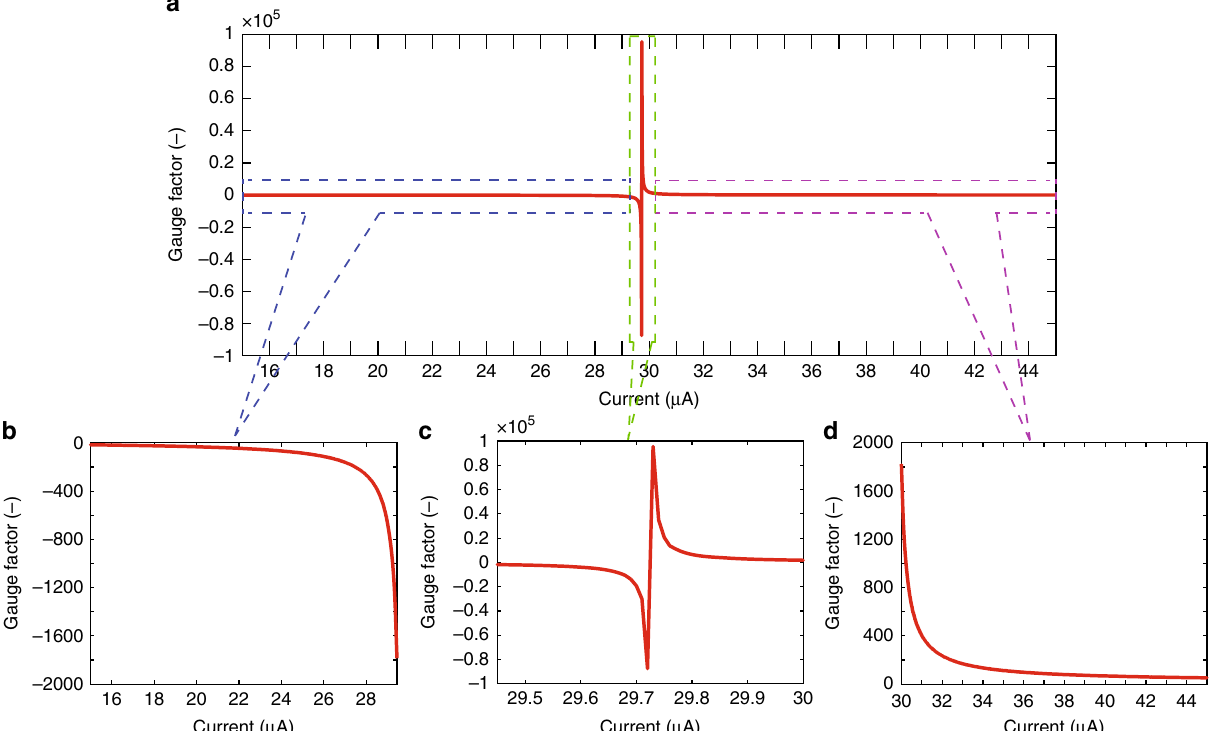
Fig. 3 The role of the tuning current in the enhancement of the piezoresistive effect. a Characteristics of GF with respect to the supplied tuning current. Three ranges of tuning current are magni fi ed in b , the negative GF range; in c , the optimal range; and in d , the positive GF range. Under the same light condition, the sensitivity (i.e., GF) changed signi fi cantly versus the supplied current. Under a light intensity of 19,000 lx, as the supplied current was swept from 15 to 45 μ A, the GF increased from approximately − 16 to a maximum of ~95,500, and then decreased to about